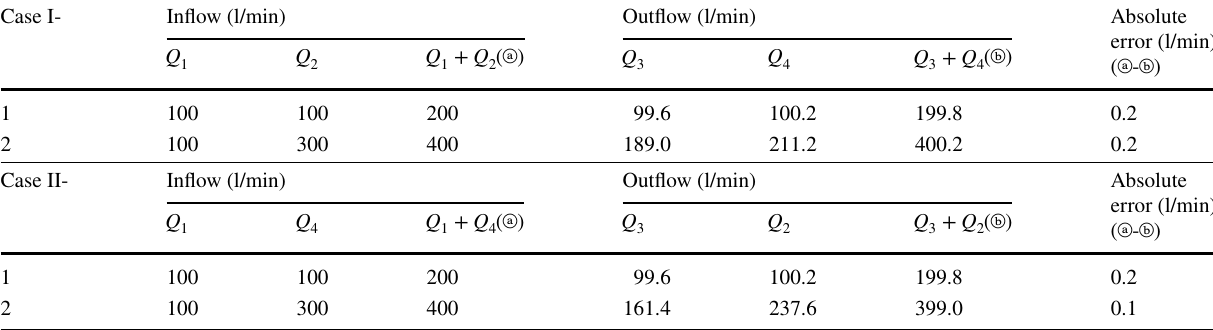
Table 2 Comparison of inflow and outflow measured in the experiment Case I- Inflow